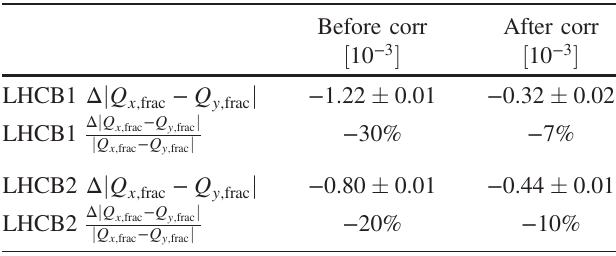
TABLE III. Change to tune separation during LHC crossing angle leveling, due to feed-down in the CMS (IR5) insertion before and after correction of normal sextupole errors. Values quoted assume that linear coupling is small in relation to the tune separation. Values in [%] are quoted relative to the minimum tune separation used during luminosity production in